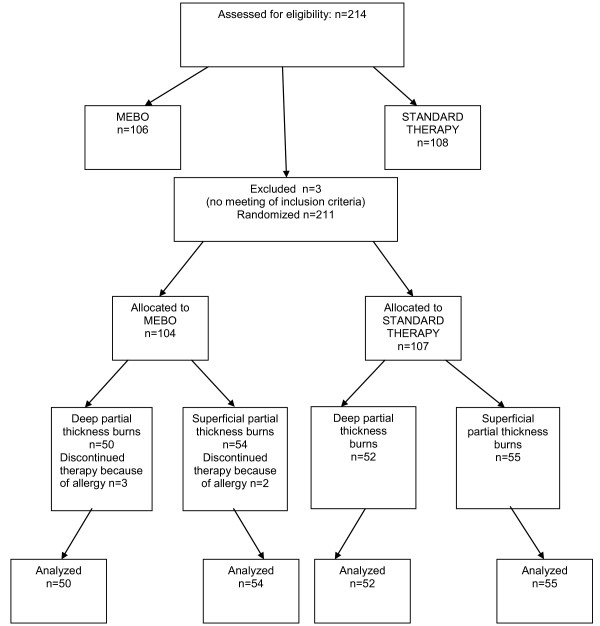
Participant flow through the trial.